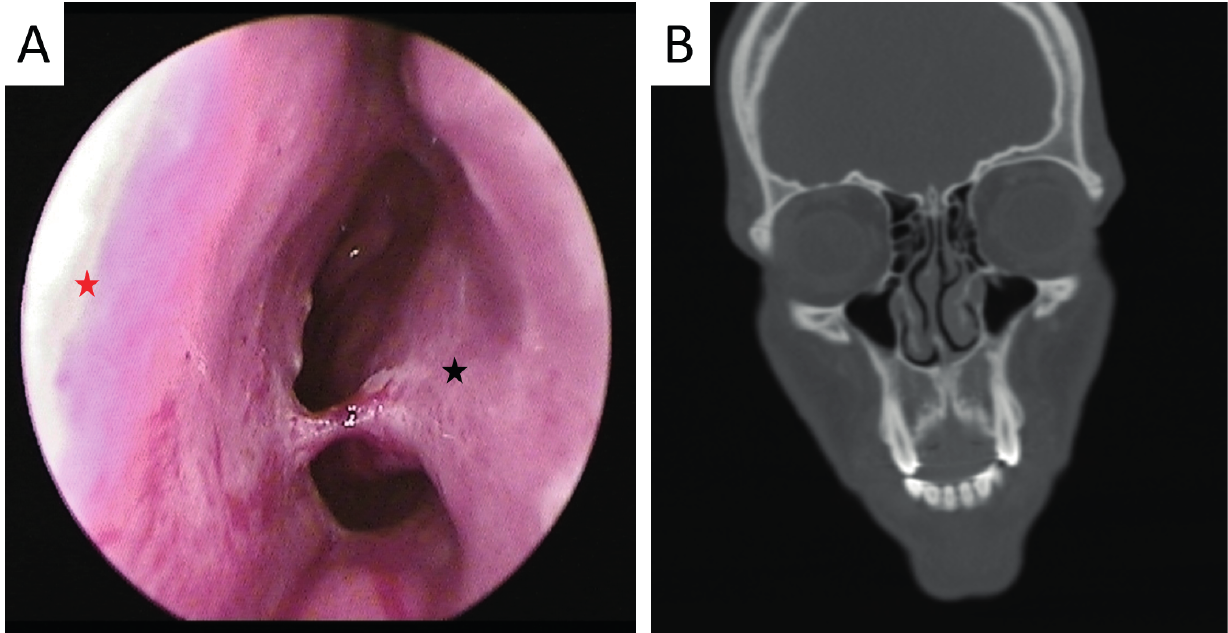
Figure 4. Post-treatment nasal endoscopy and CT-scan at three months follow-up. A. View at nasal endoscopy after treatment. The tumour has disap- peared and there is a normal nasal mucosa. A small adhesion is seen. The red asterisk indicates the nasal septum, the black asterisk the inferior turbi- nate. B. Post-treatment CT-scan of the paranasal sinuses, coronal view. Normal nasal mucosa, no tumour is